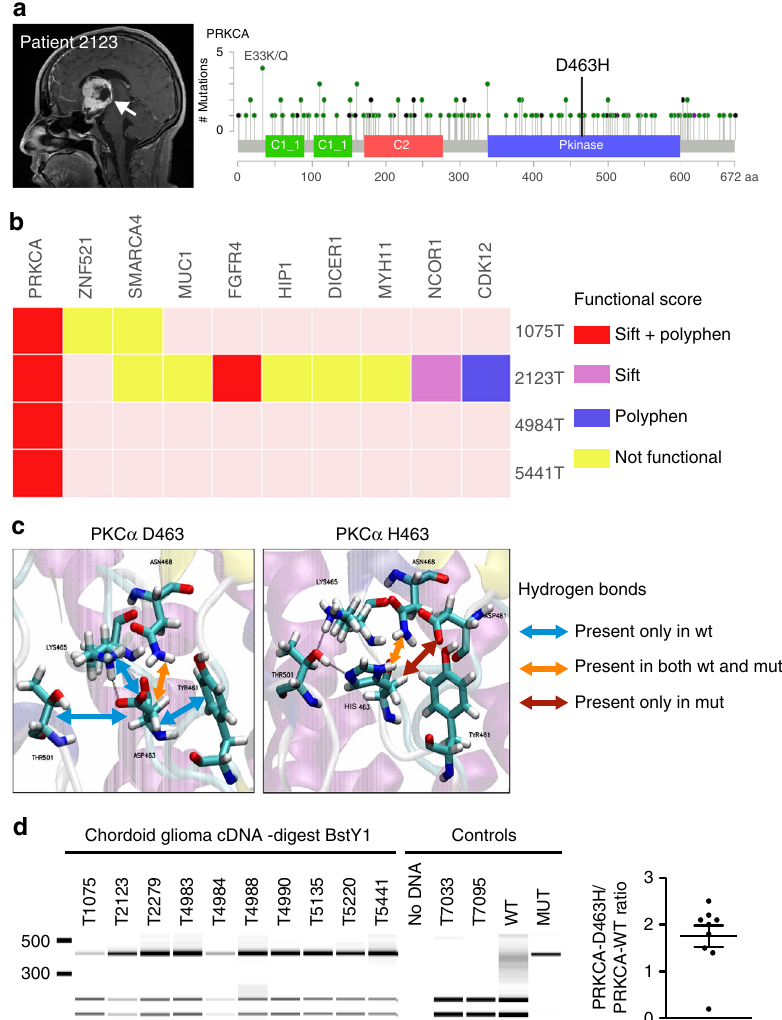
Fig. 1 Characterization of PRKCA D463H mutation in chordoid glioma. a Left panel: gadolinium T1 weighted MRI showing a well-limited, strongly enhancing mass developed at the anterior part of the third ventricule (patient 2123). Right panel: Pan-cancer PRKCA somatic mutations in TCGA cohort. D463H was not identi fi ed in this cohort and its position is marked by the straight line. b Somatic mutations in PRKCA in Cosmic census genes for the ChG samples with matched blood (G1 group). The predicted impact of the mutations according to Sift 7 and Polyphen 8 scores are given. c Three-dimensional structure of the catalytic site of PKC α showing the positions of D463 in the wild-type, H463 in the mutant protein, and the amino acids predicted to interact via hydrogen bonds with wild-type and mutant 463 residue. Hydrogen bonds identi fi ed using CHARMM software and Baker and Hubbard algorithm in MDTraj 70 python package (see Methods) are indicated by arrows: orange (common to both WT and mutant), blue (present only in WT), red (present only in the mutant). d PRKCA D463H transcript is overexpressed in ChG compared to PRKCA WT . Left: the G to C substitution leads to the loss of BstYI restriction site in the mutant allele. PCR products from ChG cDNA were digested by BstYI then analyzed by LabChIP GX. Lanes T7033 and T7095 correspond to cDNA from low-grade glioma wild type for PRKCA , which shows that digestion ef fi ciency is 100%. Mutant product size appears arround 418 bp; wild type digested product sizes appears around 227 and 185 bp. The last two lanes correspond to pcDNA plasmid controls, either WT or D463H mutant (MUT). Right: concentration ratio of mutant to wild-type bands is indicated (mean = algorithms (CLU_PSAP and CLU_VIM) (Supplementary Fig. 4). No fusion involving a COSMIC gene was identi fi ed by more than one algorithm.